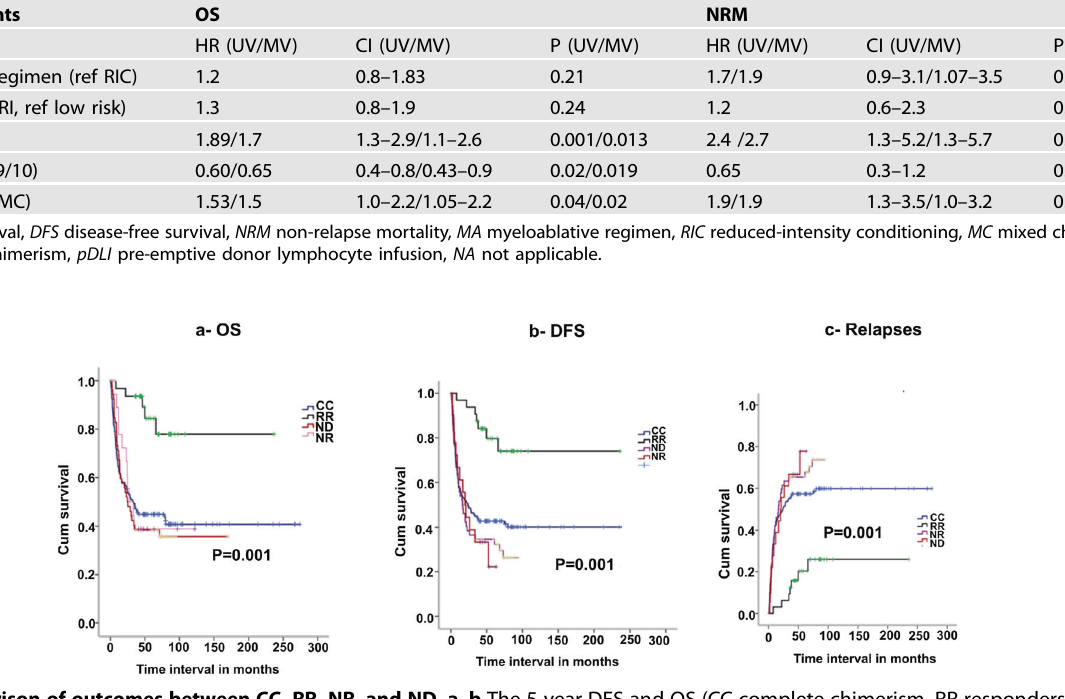
Fig. 2 Comparison of outcomes between CC, RR, NR, and ND. a , b The 5-year DFS and OS (CC complete chimerism, RR responders, NR non- responder, ND No DLI). c Relapses (CC complete chimerism, RR responders, NR non-responder, ND No DLI).